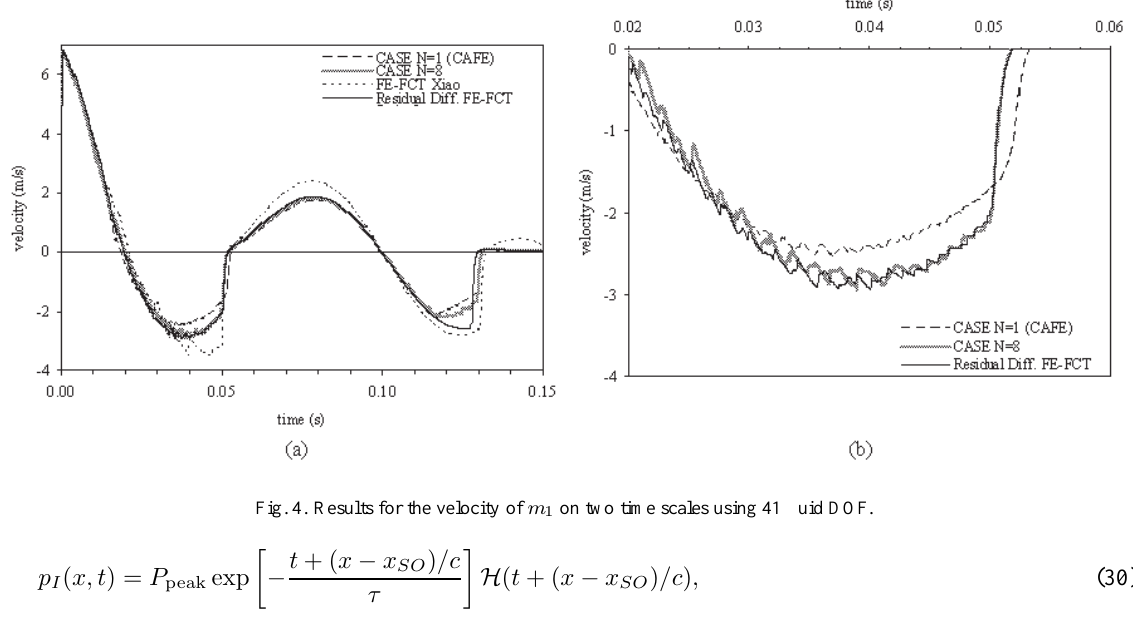
Fig. 4. Results for the velocity of m 1 on two time scales using 41 fluid